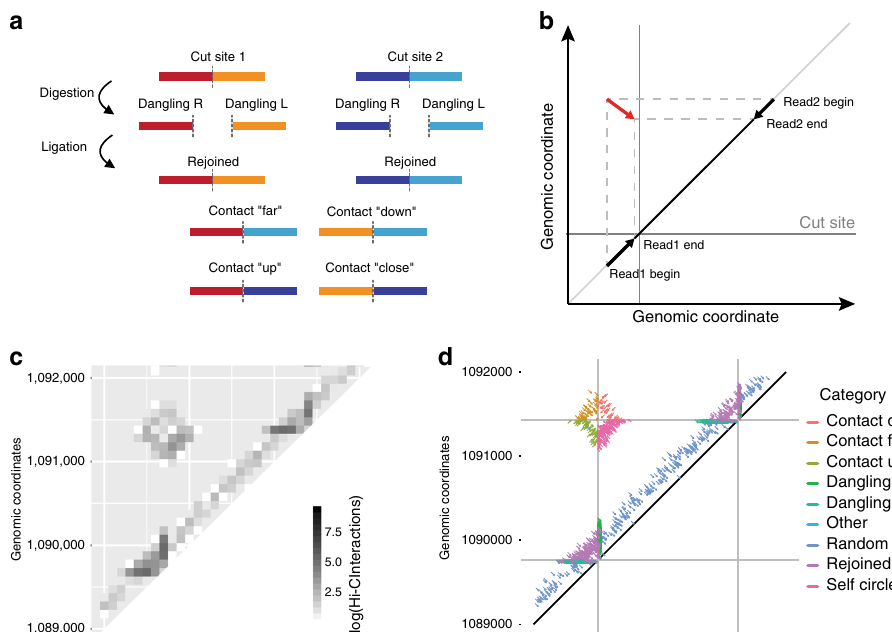
Fig. 6 Classi fi cation of reads into categories used for Binless. a Reads are classi fi ed into dangling, rejoined ends and contacts. b Each paired-end read is represented by an arrow. Horizontal and vertical projections on the diagonal reveal the position and direction in which the read was mapped. c Zoomed Hi-C map of Caulobacter crescentus at 100 bp resolution with the apparent cut-site enrichment of interactions as a square in in the matrix. d Same data as in c now represented using arrows, with colors according to the Binless classi fi cation. Vertical and horizontal lines are cut site locations, while diagonal gray line represents the diagonal of the Hi-C